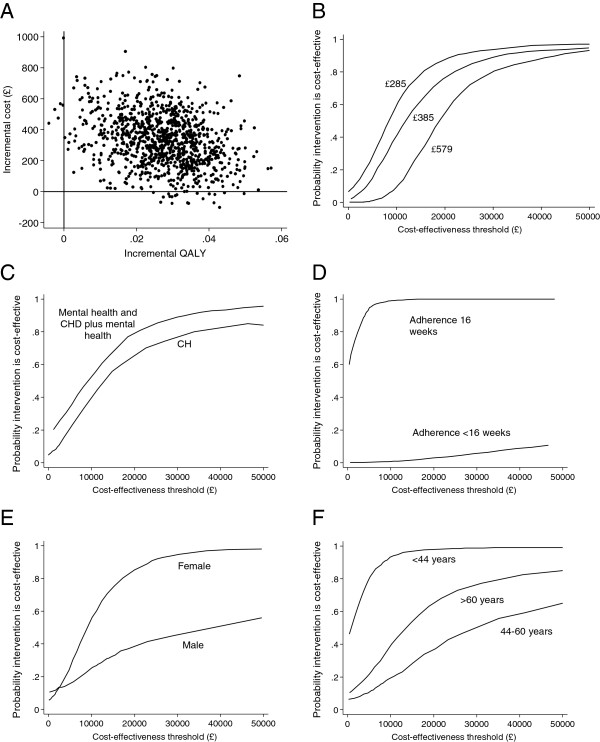
Cost-effectiveness planes with 1,000 bootstrapped ICER estimates for NERS economic evaluation. Cost-effectiveness planes for base case (A), cost-effectiveness acceptability curves for three intervention costs of £285, £385 (base case) and £579 (B), and for participant subgroups with different referral reason to NERS (C), adherence to NERS (D), gender (E), and age of participants (F).